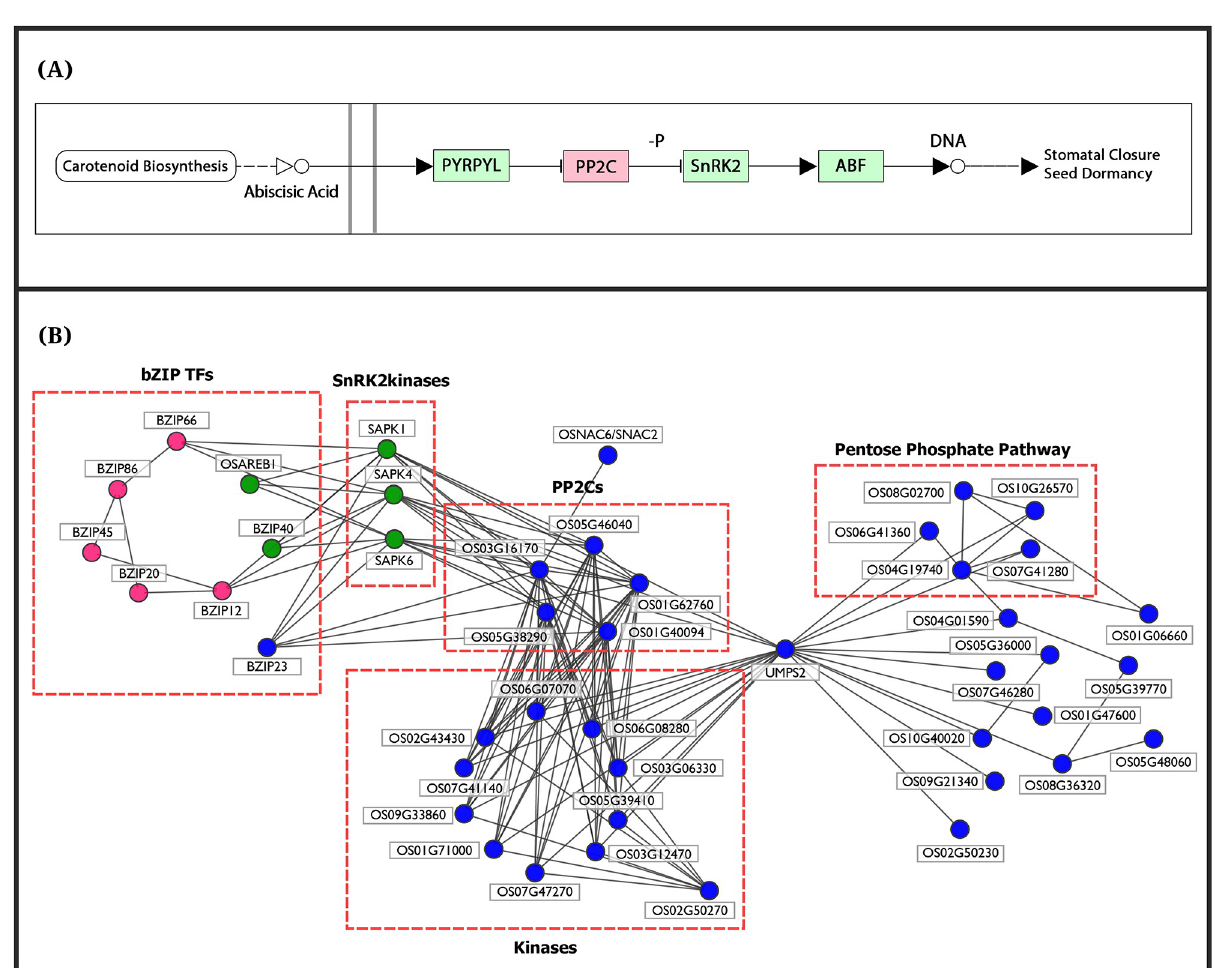
Fig 3. (A) Components of ABA signalosome complex: PYR/PYL receptors, PP2Cs, SnRK2 kinases and ABF/bZIP transcription factors are depicted (reproduced from KEGG). (B) Subnetwork of Cluster U1 (‘blue’), Cluster U10 (‘green’) and Cluster U13 (‘pink’) obtained using MCL algorithm on up- regulated drought-tolerant network (uDTN) is seen to capture the crosstalk between the signalling components: PP2Cs, kinases, bZIP23, OsNAC6, SnRK2 kinases (Cluster U1), bZIPs (Cluster U1 and Cluster U13) with metabolic components of Cluster U1 via UMPS2. This clearly indicates the role of UMPS2 as a novel candidate for